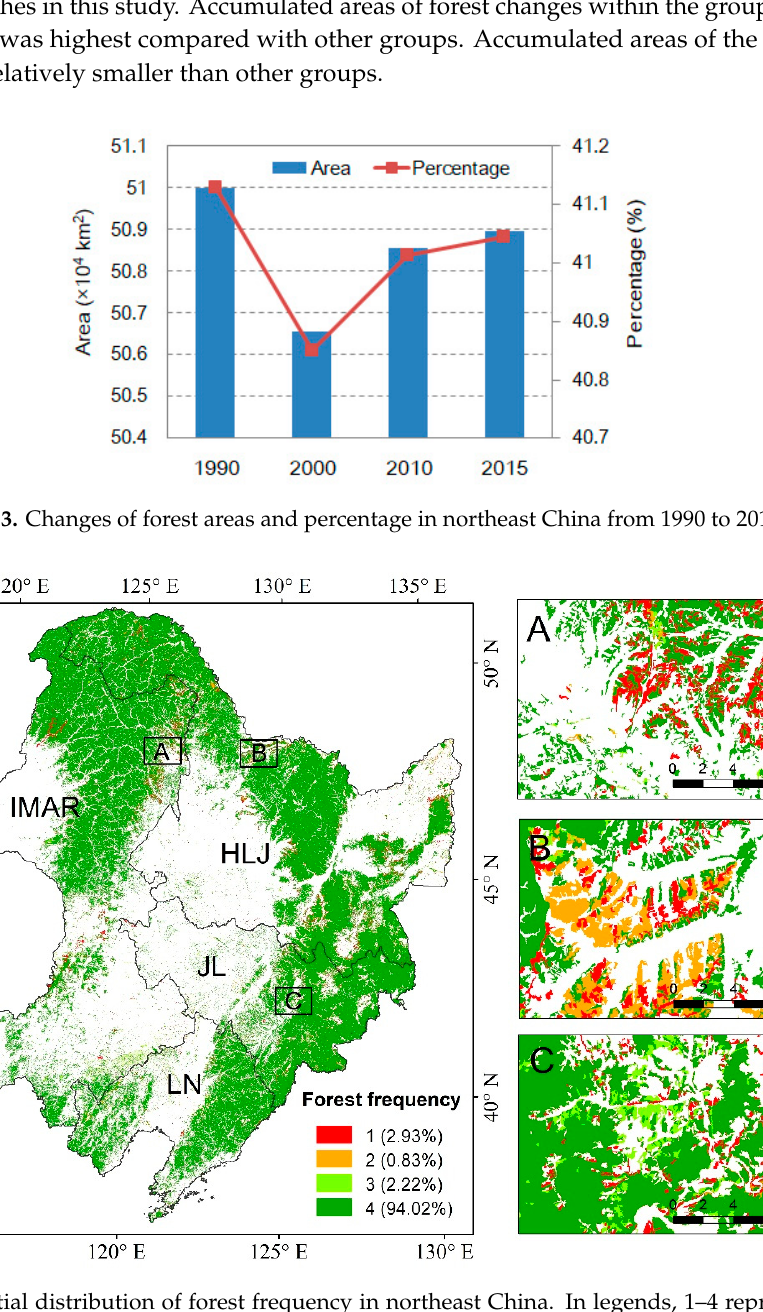
Figure 4. Spatial distribution of forest frequency in northeast China. In legends, 1–4 represent the number of years a pixel was identified as forests during 1990–2015, and the percentage values were their proportion to the total forest area.